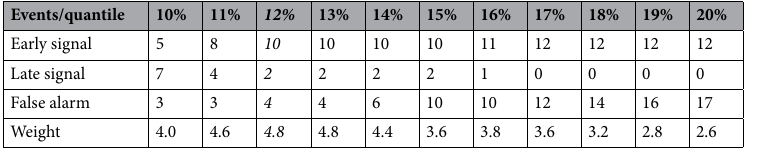
Table 3. List of possible quantile values for the FLEWS from the time series of the L dimensional persistence landscapes with their respective results and weights.